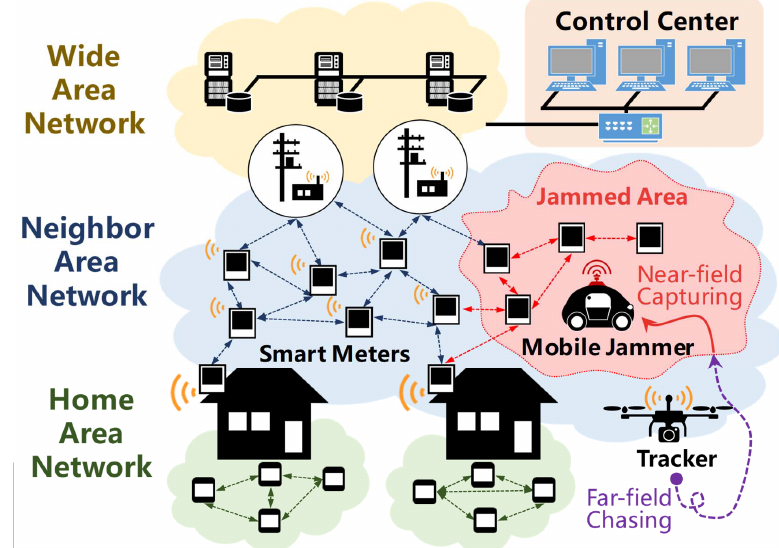
Figure 1. A jamming attack scenario in the neighbor area network of an